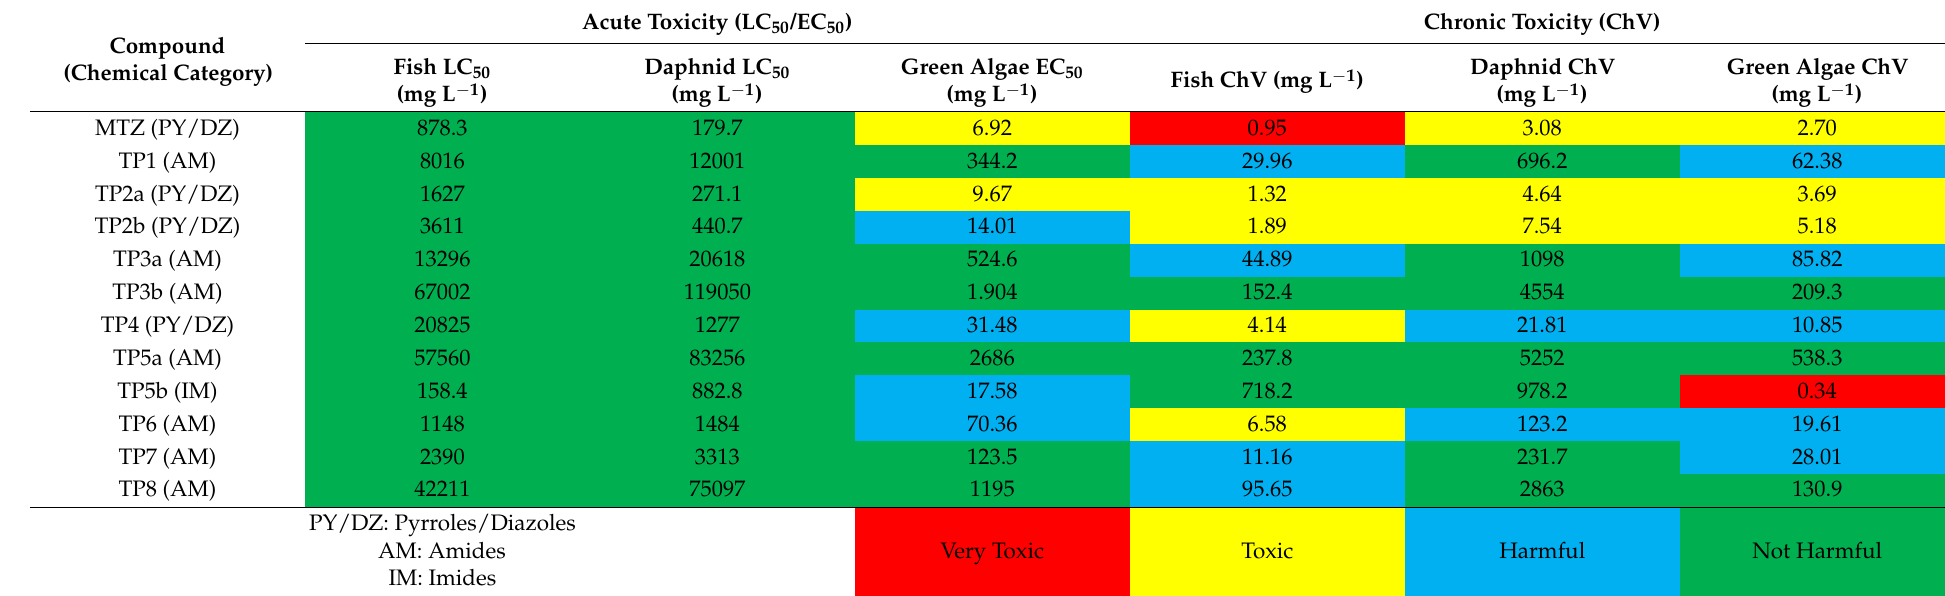
Table 2. In silico predicted values of acute and chronic toxicity of MTZ and its identified